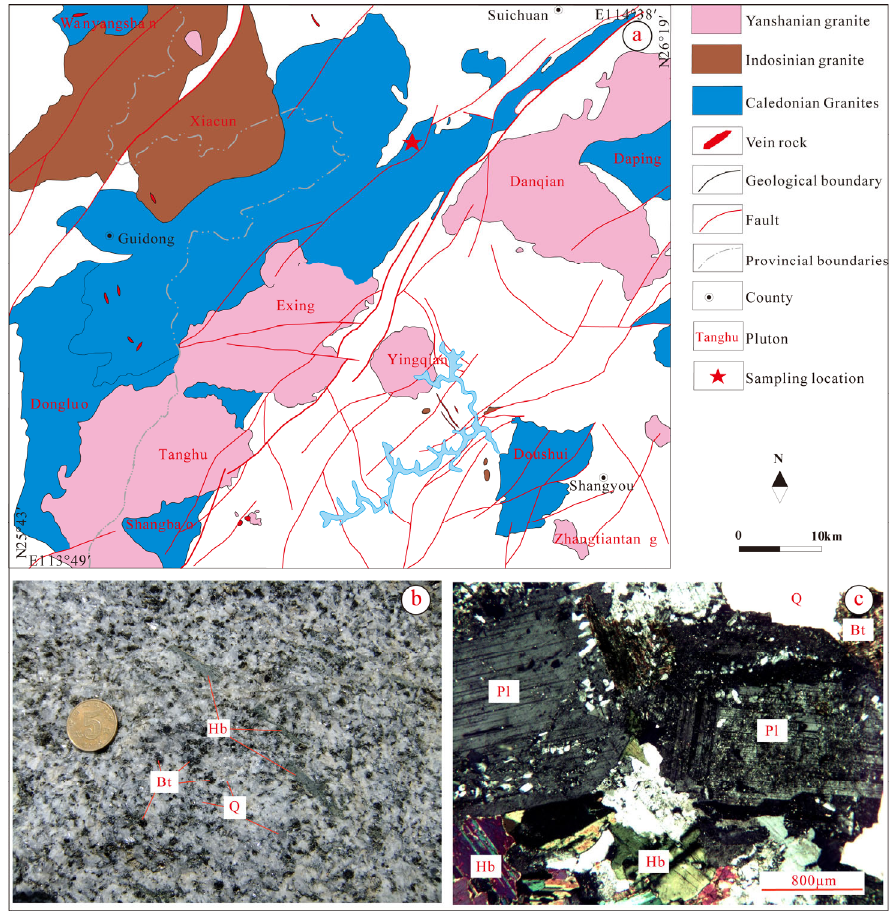
Figure 3. Geological sketch map of the north Zhuguangshan area ( a ); Outcrop ( b ) and orthogonal polarizing micrograph ( c ) of the Tanghu granite. The location of Figure 3a has been shown in Figure